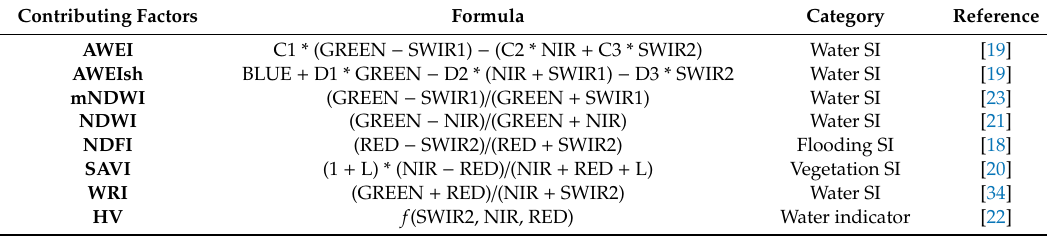
Table 3. Selected spectral indexes used as contributing